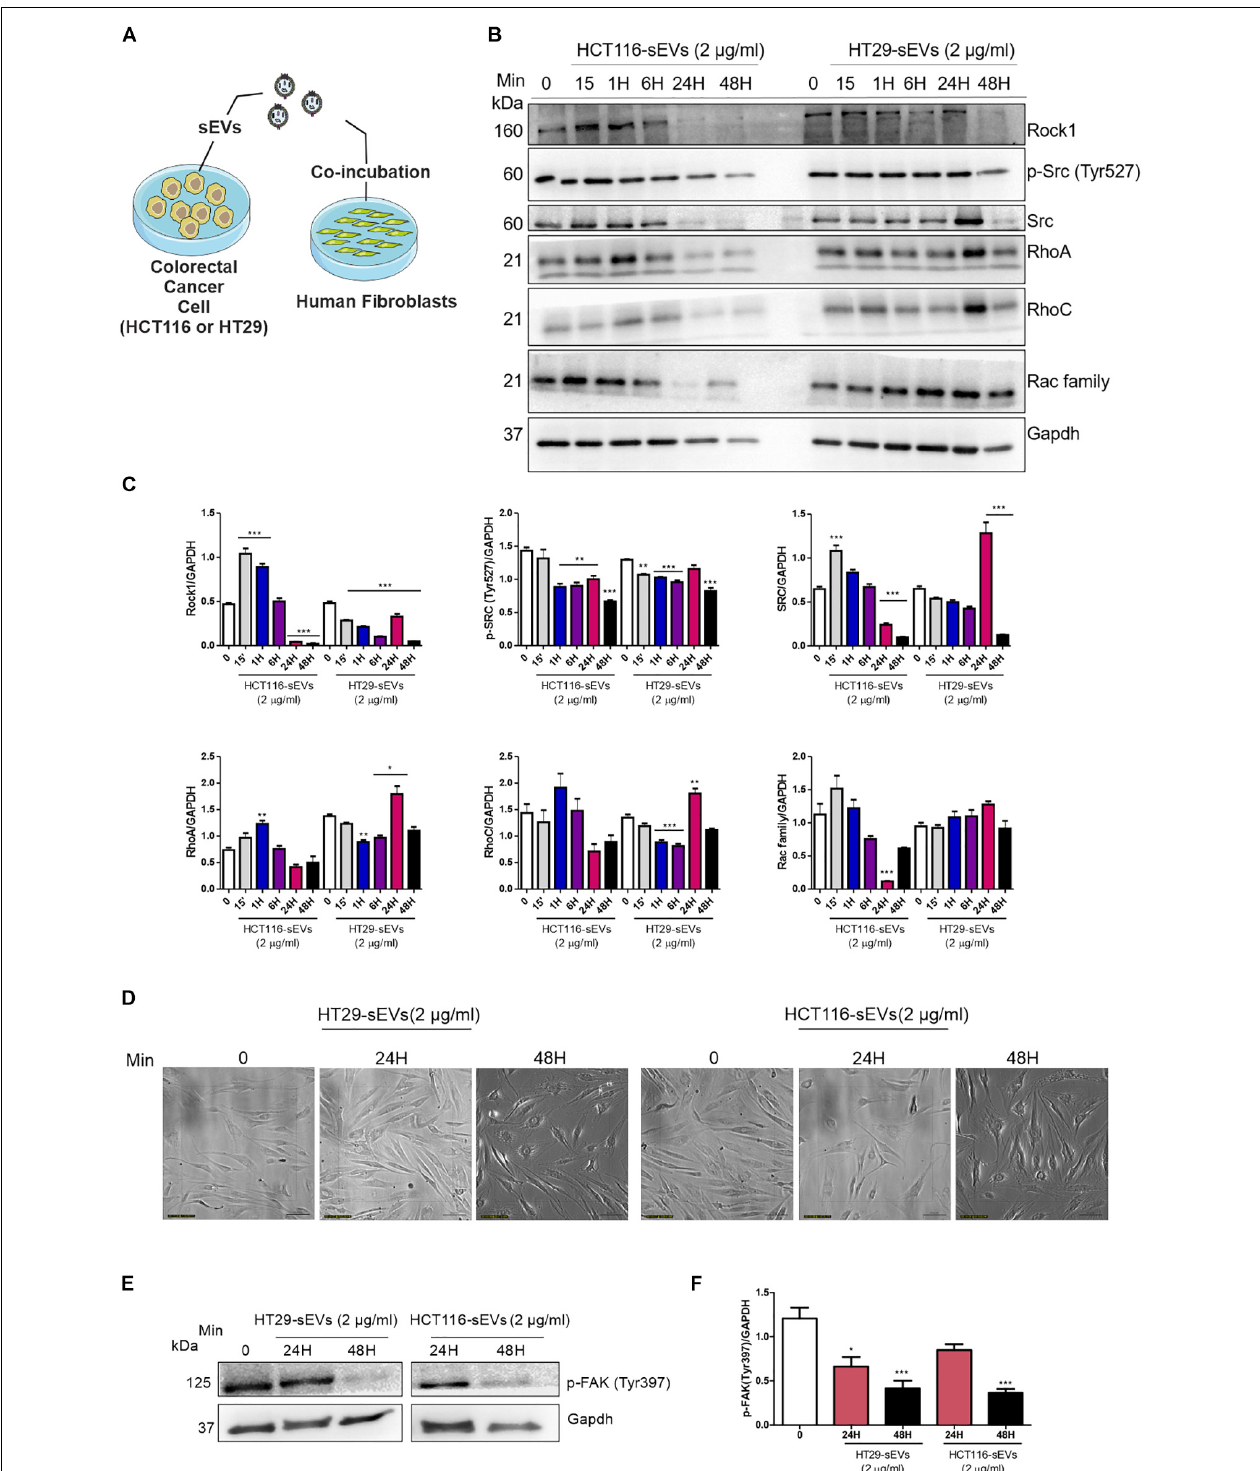
FIGURE 5 | Western Blotting analysis. (A) Schematic diagram of the experimental procedures. Human fibroblasts were exposed to one dose of 2 µ g/ml of HCT116 and HT29 cell-derived sEVs for 15 min, 1, 6, 24, and 48 h as indicated or vehicle (PBS t = 0). (B,E) Western blot was used to analyze cell lysates with the indicated antibodies. GAPDH serves as a loading control. (C,F) Densitometry values were corrected for loading controls. ( N = 3 independent experiments). Values are represented as mean ± SEM. * P < 0.05, ** P < 0.01, and *** P < 0.001, assessed with one way-ANOVA followed by Tukey post-test. (D) Bright field representative images of human fibroblast exposed to HCT116 and HT29 cell-derived sEVs followed each treatment time. Scale bar: 100 µ m.